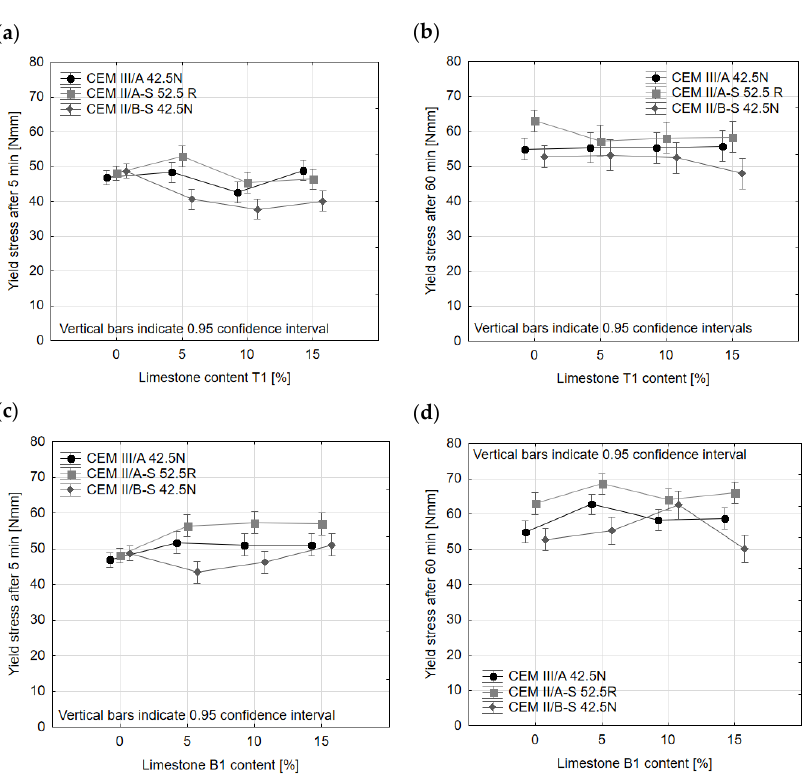
Materials 2021 , 14 , x FOR PEER REVIEW Figure 5. Yield stress of slag-limestone cement after 5 min ( a , c ) and 60 min ( b , d ) from adding water to cement.